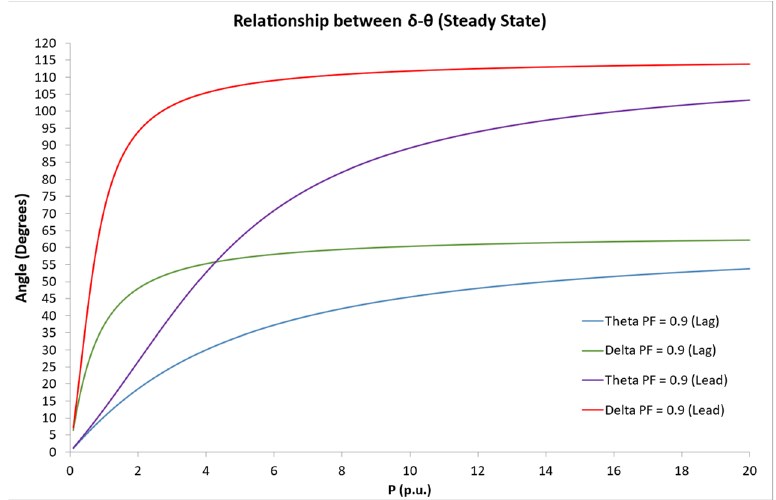
Figure 5. Relationship between δ and θ for different load